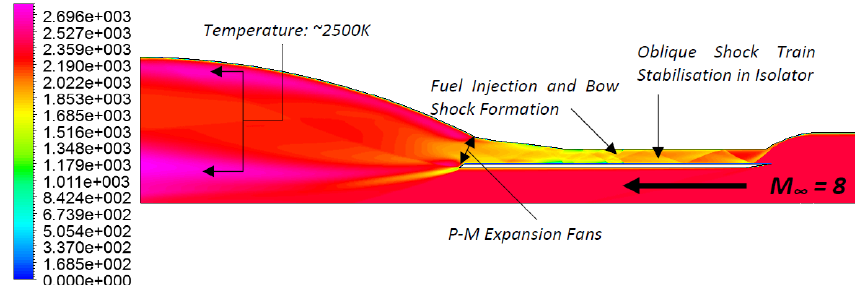
Figure 28. Velocity (in m/s) contour for transverse injection of a full scramjet engine in 2-D.